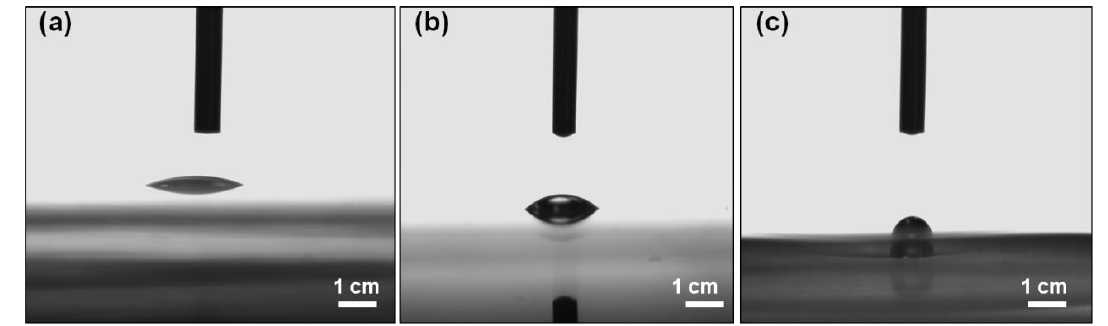
Figure 6. Contact angle measurement for water droplets on ( a ) glass slides; ( b ) PET and ( c ) IC film substrates.